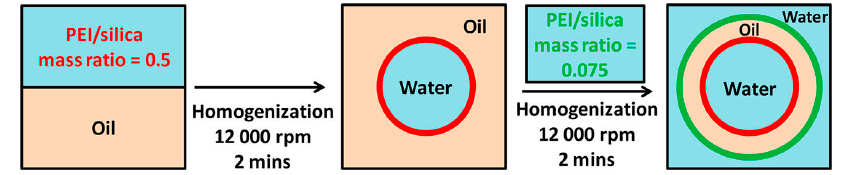
Figure 4. Schematic representation of preparing water-oil-water (W/O/W) double emulsions using poly(ethylene imine)-modified silica particles. Reprinted with permission from [80]. Copyright 2014, American Chemical Society.